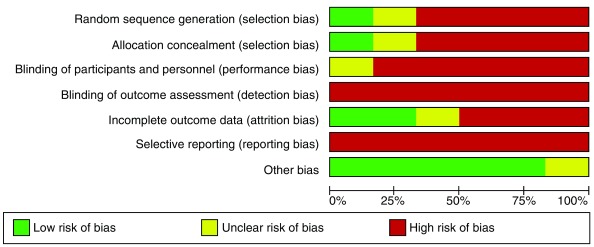
Risk of bias graph.